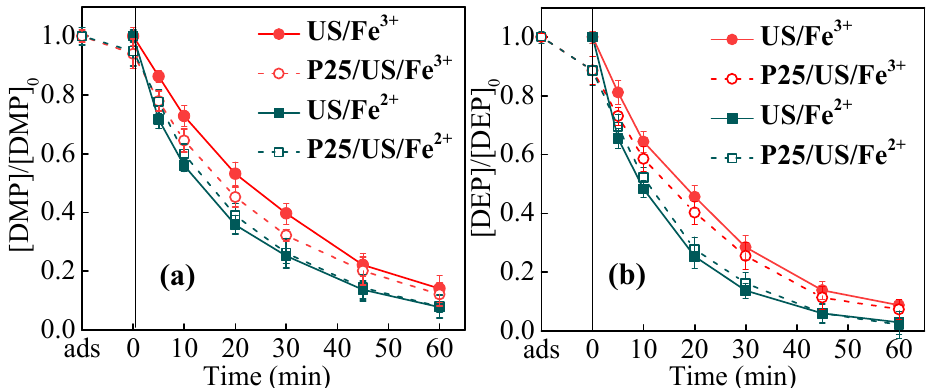
Figure 2. Influence of P25 on the degradation of ( a ) DMP and ( b ) DEP in dark sono-Fenton and sono-Fenton-like processes ([DMP] 0 = 0.01 mM, [DEP] 0 = 0.01 mM, P25 dosage 0.5 g L −1 , adsorption time 20 min, [Fe 2+ ] 0 = 0.5 mM, [Fe 3+ ] 0 = 0.5 mM).